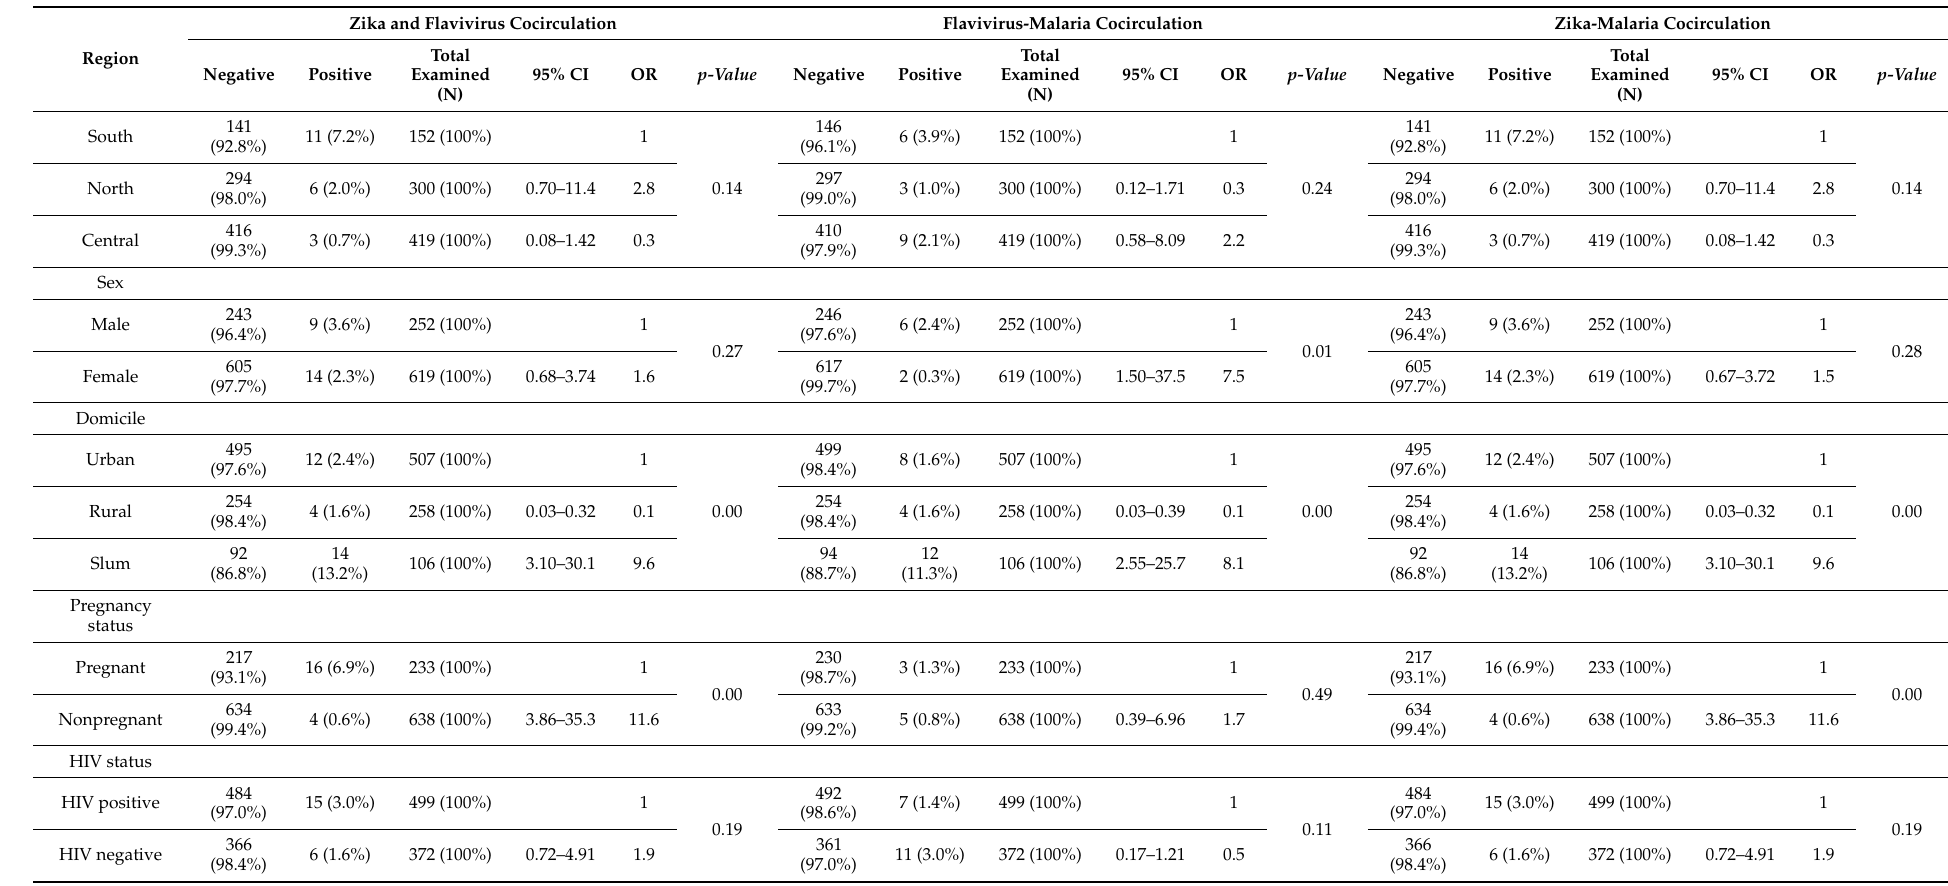
Table 4. Cocirculation antibody seropositivity of ZIKV, FLAVI and